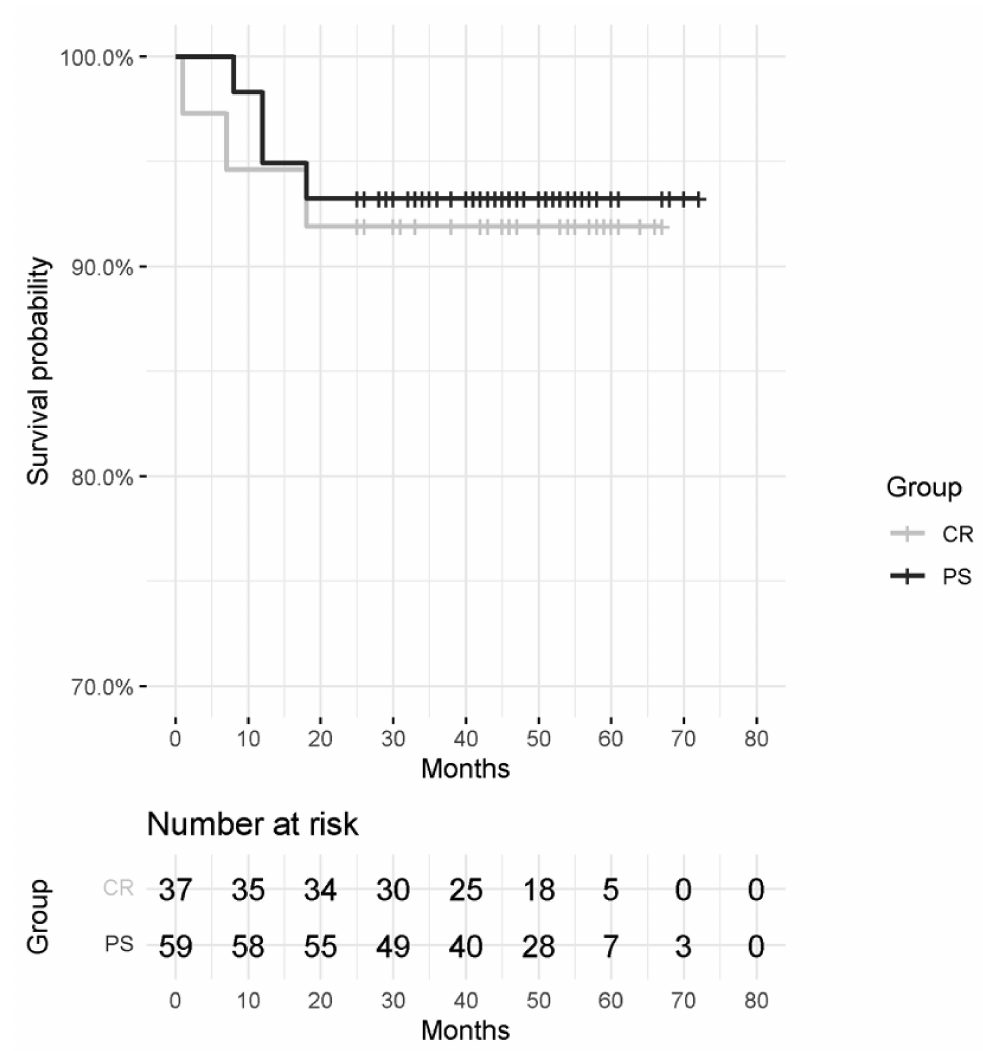
Figure 1. Kaplan-Meier curves and survival probabilities for each